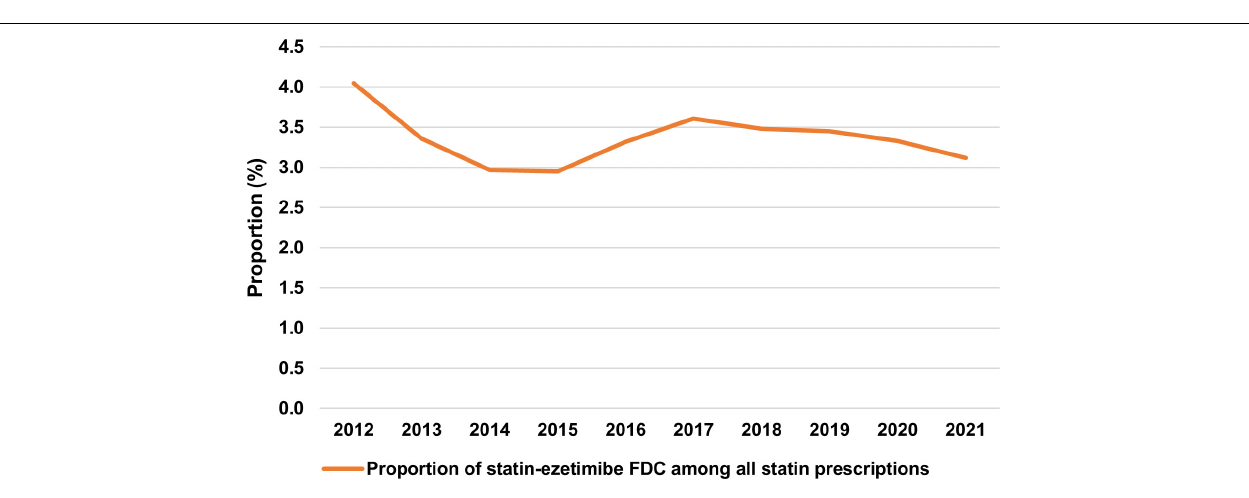
therapy could be established in approximately 50% of patients with prior symptoms (19).